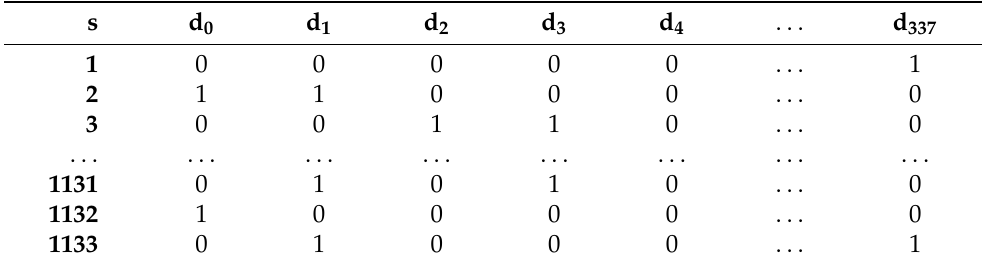
Table 7. Sample table of Discussion participation.